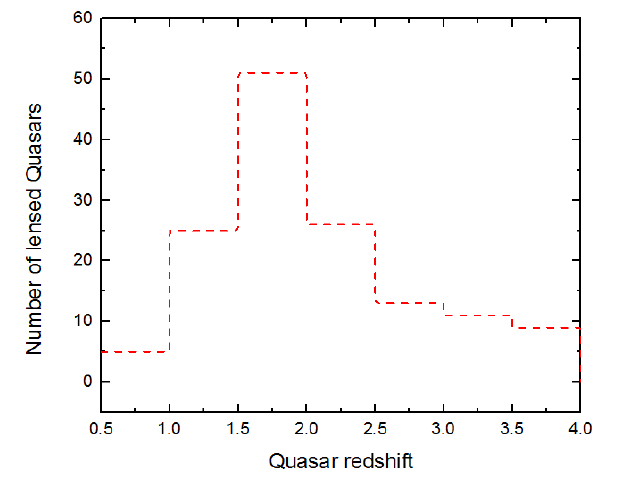
Figure 3. Histogram of the redshift distribution for the 140 expected Quasars, lensed by foreground galaxies, and detectable by